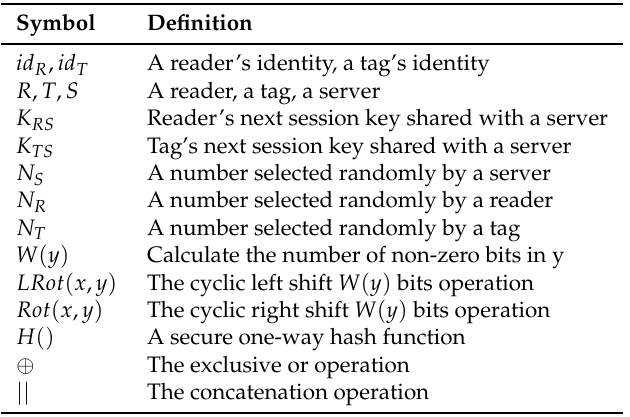
Table 1. Symbols used in the